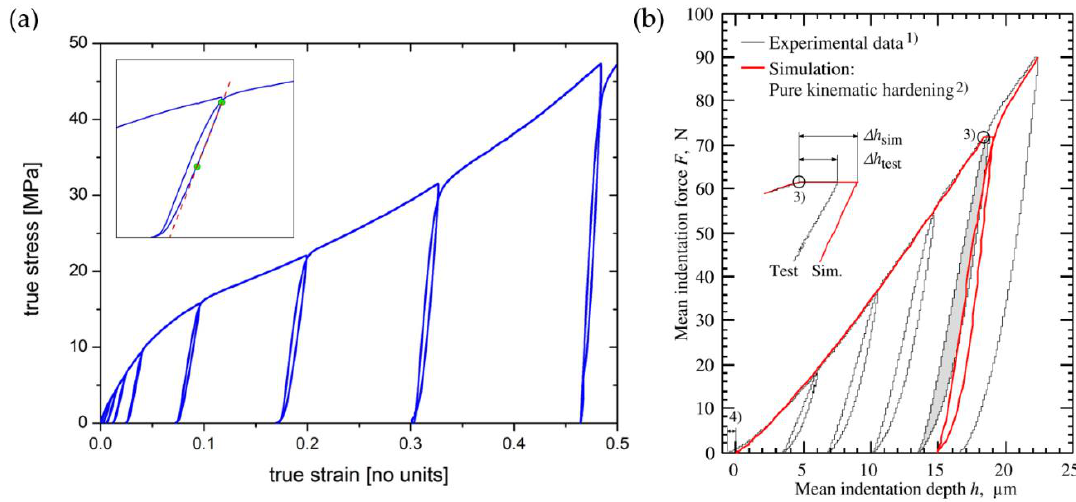
Figure 21. Material response for compression with inserted unloading–reloading cycles: ( a ) Macroscopic stress–strain curves measured for np-Au, reprinted from [89] with permission of Elsevier; ( b ) Force-displacement curves measure for TiAl with spherical indentation [143], reproduced with permission of Cambridge University Press.